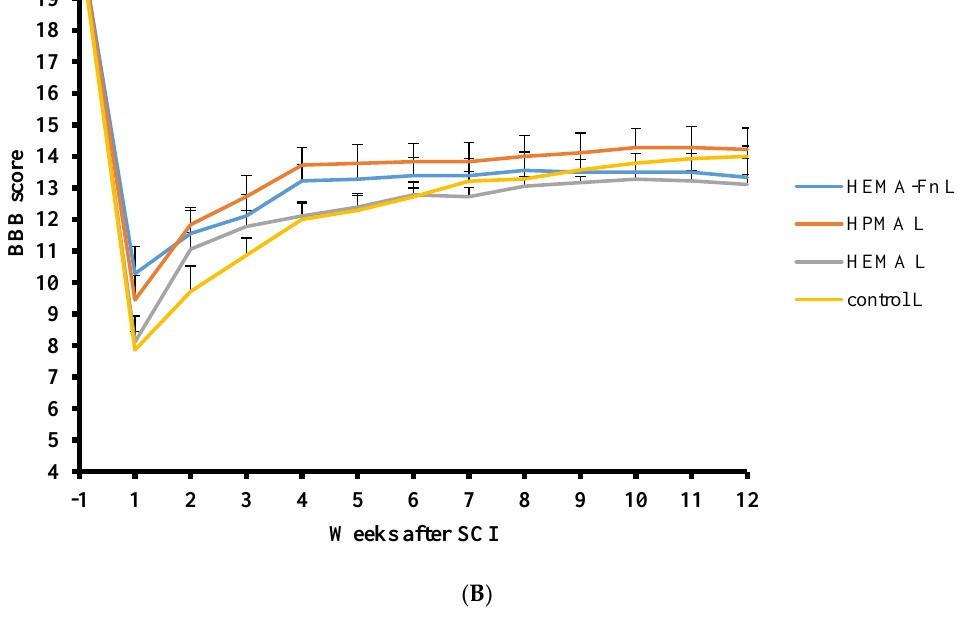
Figure 2. Comparison of motor function evaluation of the injured ( A ) and uninjured ( B ) side of hindlimbs using the BBB score. There were no statistically significant differences among the four groups (three treatment groups and one control group-hemisection only). Note the lower scores of the injured hindlimb on the side of the hemisection. The data represent mean values and error bars represent SEM.